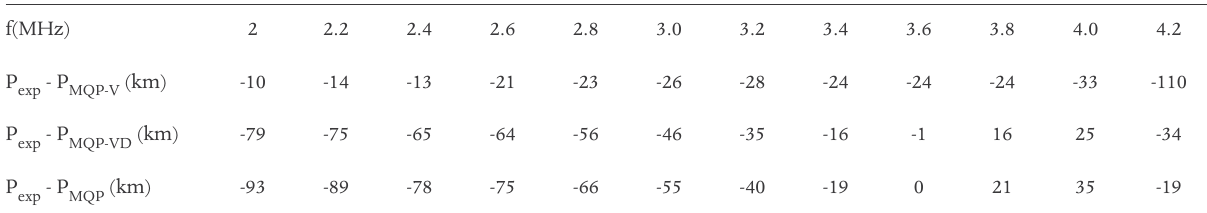
Table 1. Difference values in the one-hop group paths of the experimental oblique sounding and of the simulation results. Time: January 3, 2014, at 16:22